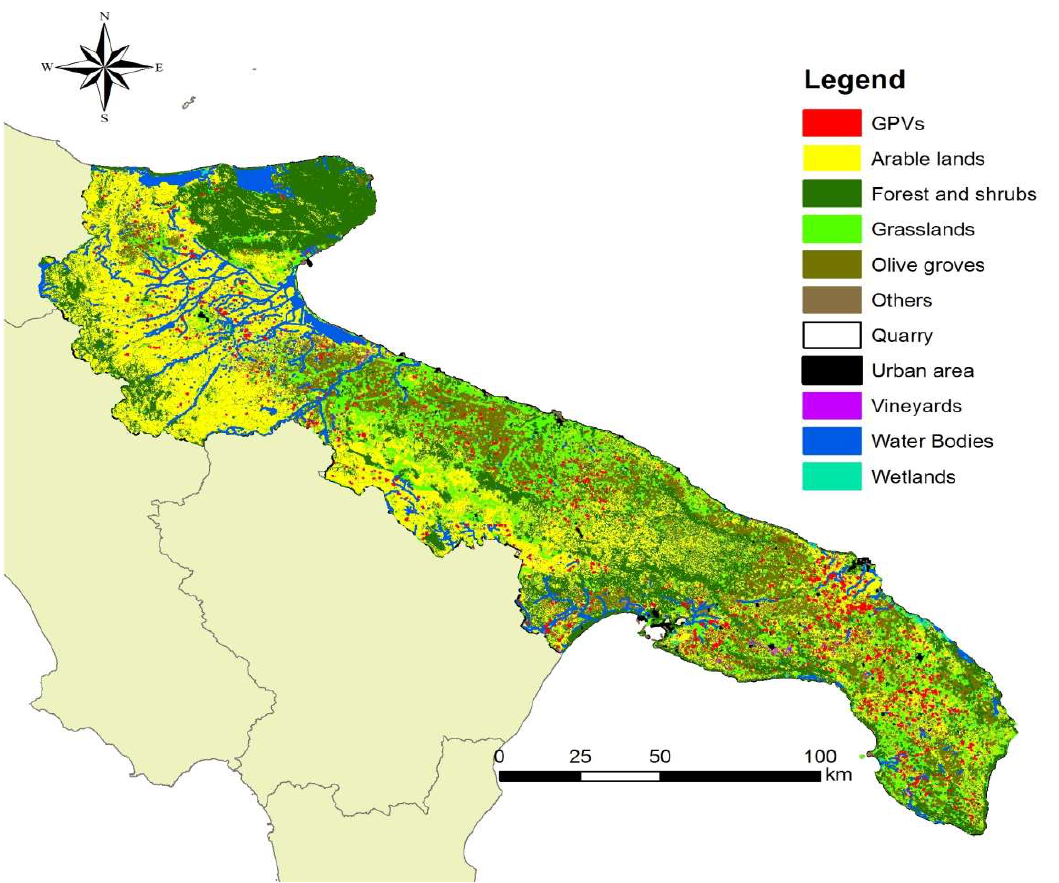
Figure 3. GPV systems realised until 2016 and land use in the Apulia region. Land use data sources from [74].